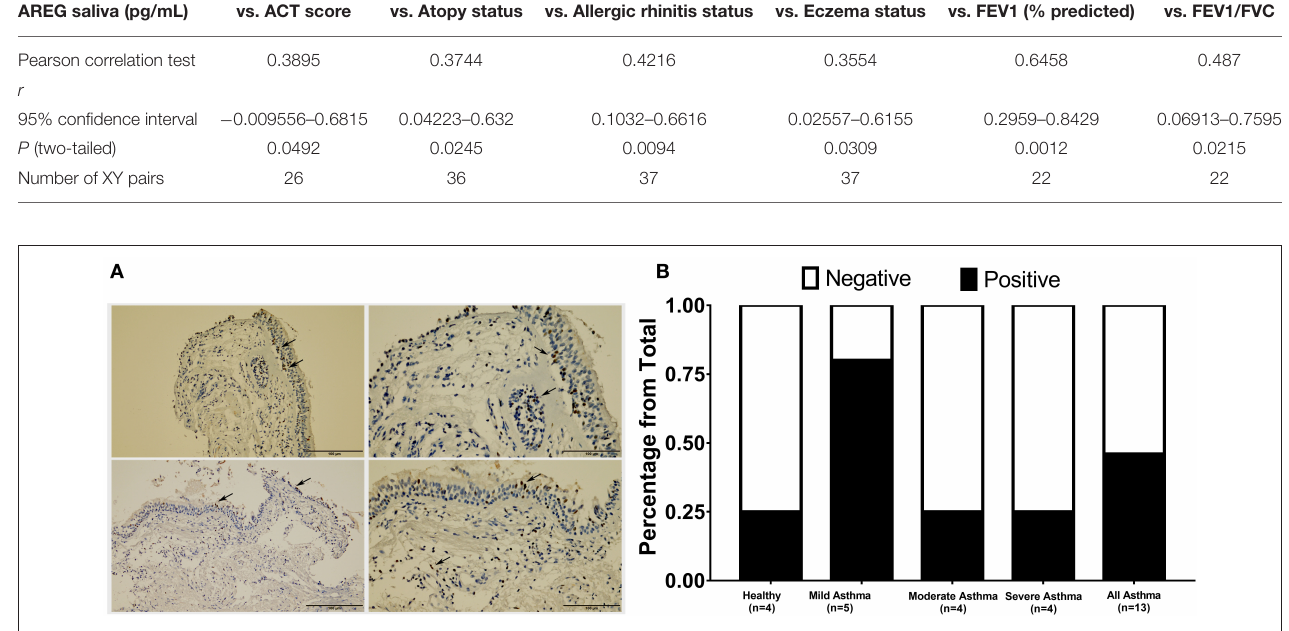
FIGURE 4 | Immunohistochemical staining of AREG in bronchial biopsies of healthy, non-severe (mild and moderate) and severe asthmatic patients. (A) Arrows showing positively stained epithelial cells, (B) percentage of positive AREG IHC staining sample among all samples examined in each